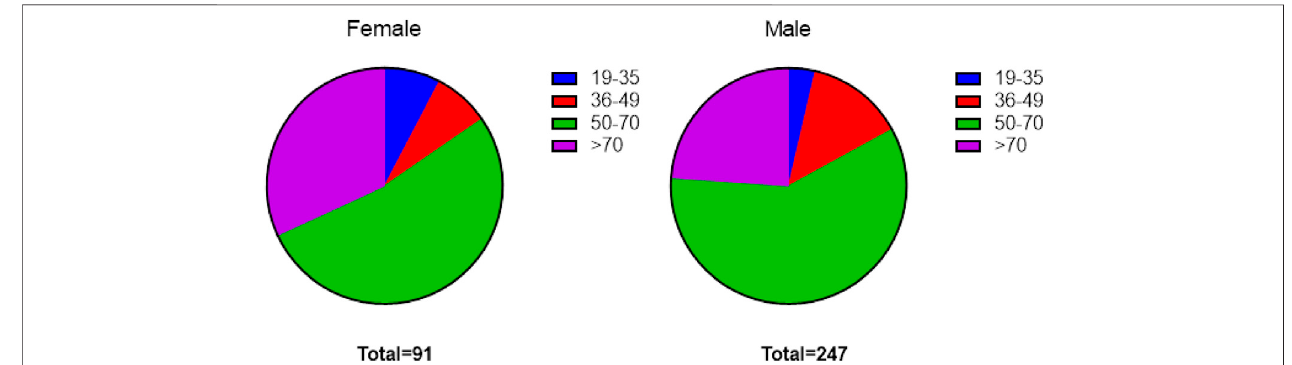
FIGURE 7 | Age groups of participants.